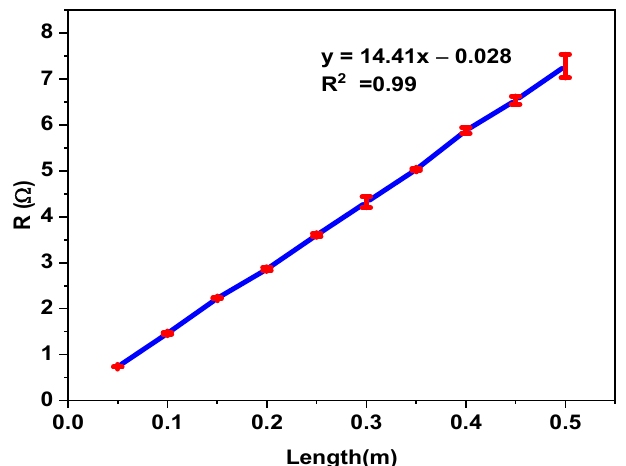
Figure 5. Length-dependent resistance of stainless steel conductive yarn.